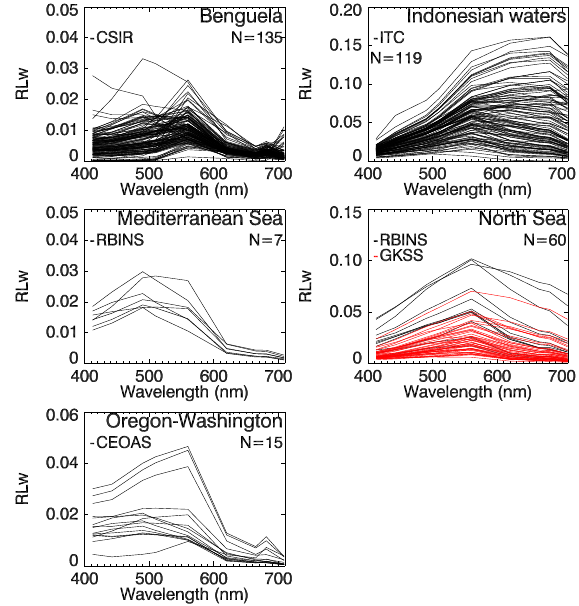
Figure 20. The in situ reflectance spectra provided from five Coast- Colour sites. Note the different scales used for the sites. The spectra from the North Sea site coloured in red are provided by